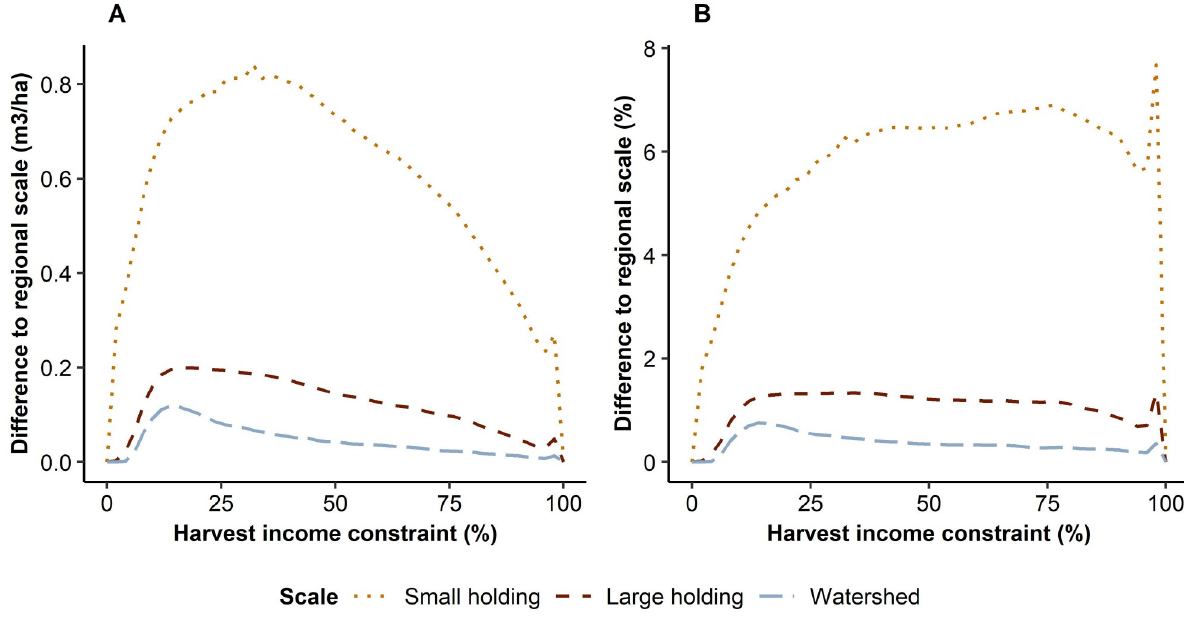
Fig 4. Differences in deadwood availability among scales. Improvement gained from increasing the scale of management optimization from the three smaller scales to the regional scale expressed as the absolute (panel A) and relative (panel B) difference in deadwood